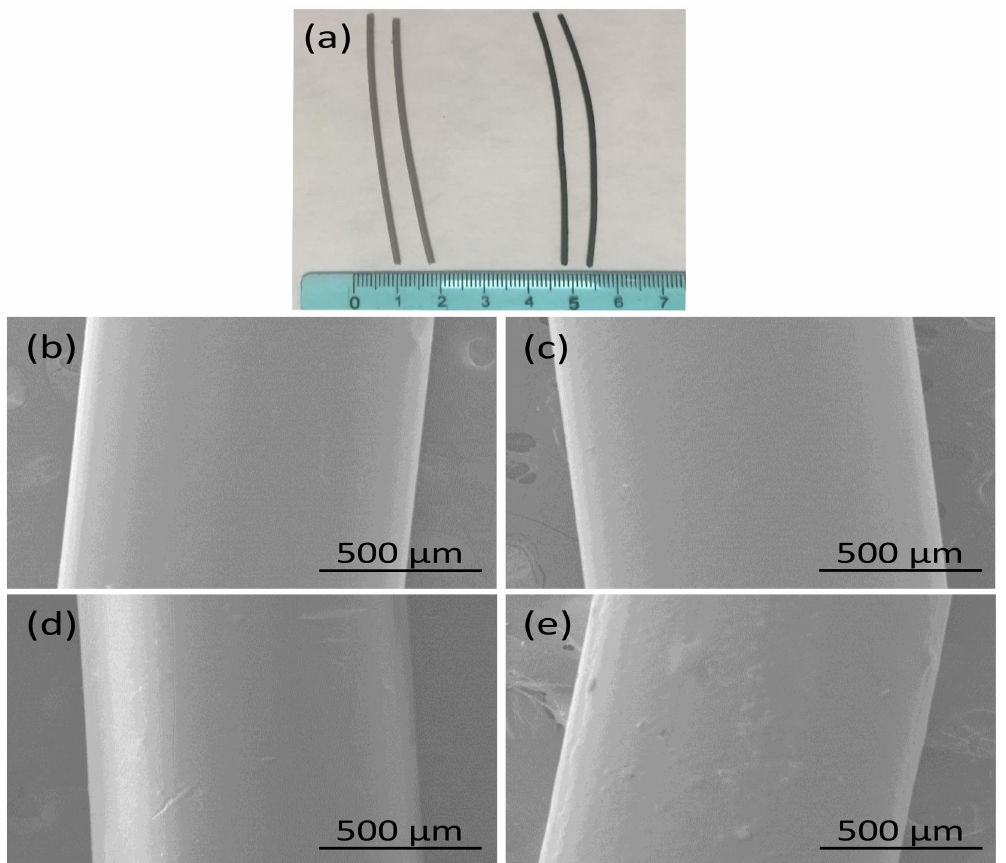
Figure 1. ( a ) Photographs of extruded neat PEEK (left) and GnP-loaded PEEK filaments (right). Surface SEM images of ( b ) Neat PEEK ( c ) 0.5 wt.% ( d ) 1.0 wt.% ( e ) 3.0 wt.% GnP fillers-loaded PEEK